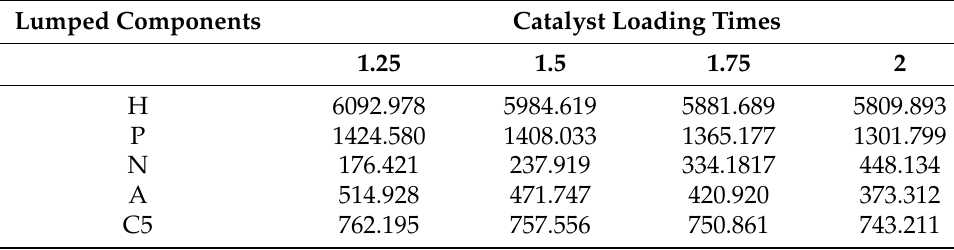
Figure 8. Internal temperature changes of each reactor. Table 3. Units for Magnetic Properties and the effect of catalyst loading on each lumped